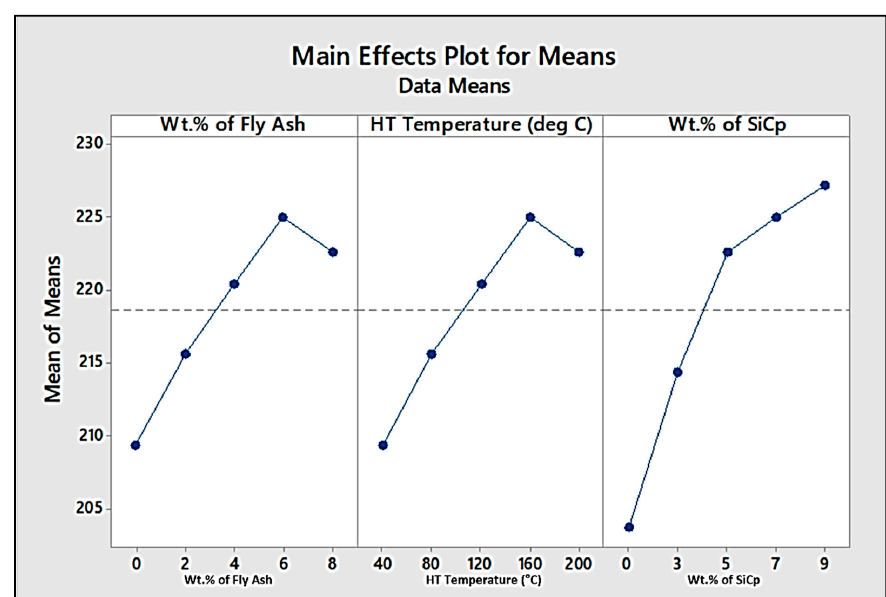
Figure 22. Main-effect plot for means for UTS.